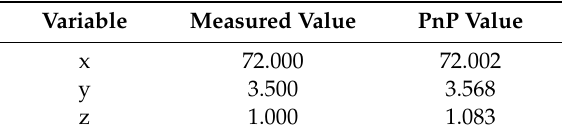
Table 3. Discrepancies between measuring the position of the luminance meter manually or using the PnP method.